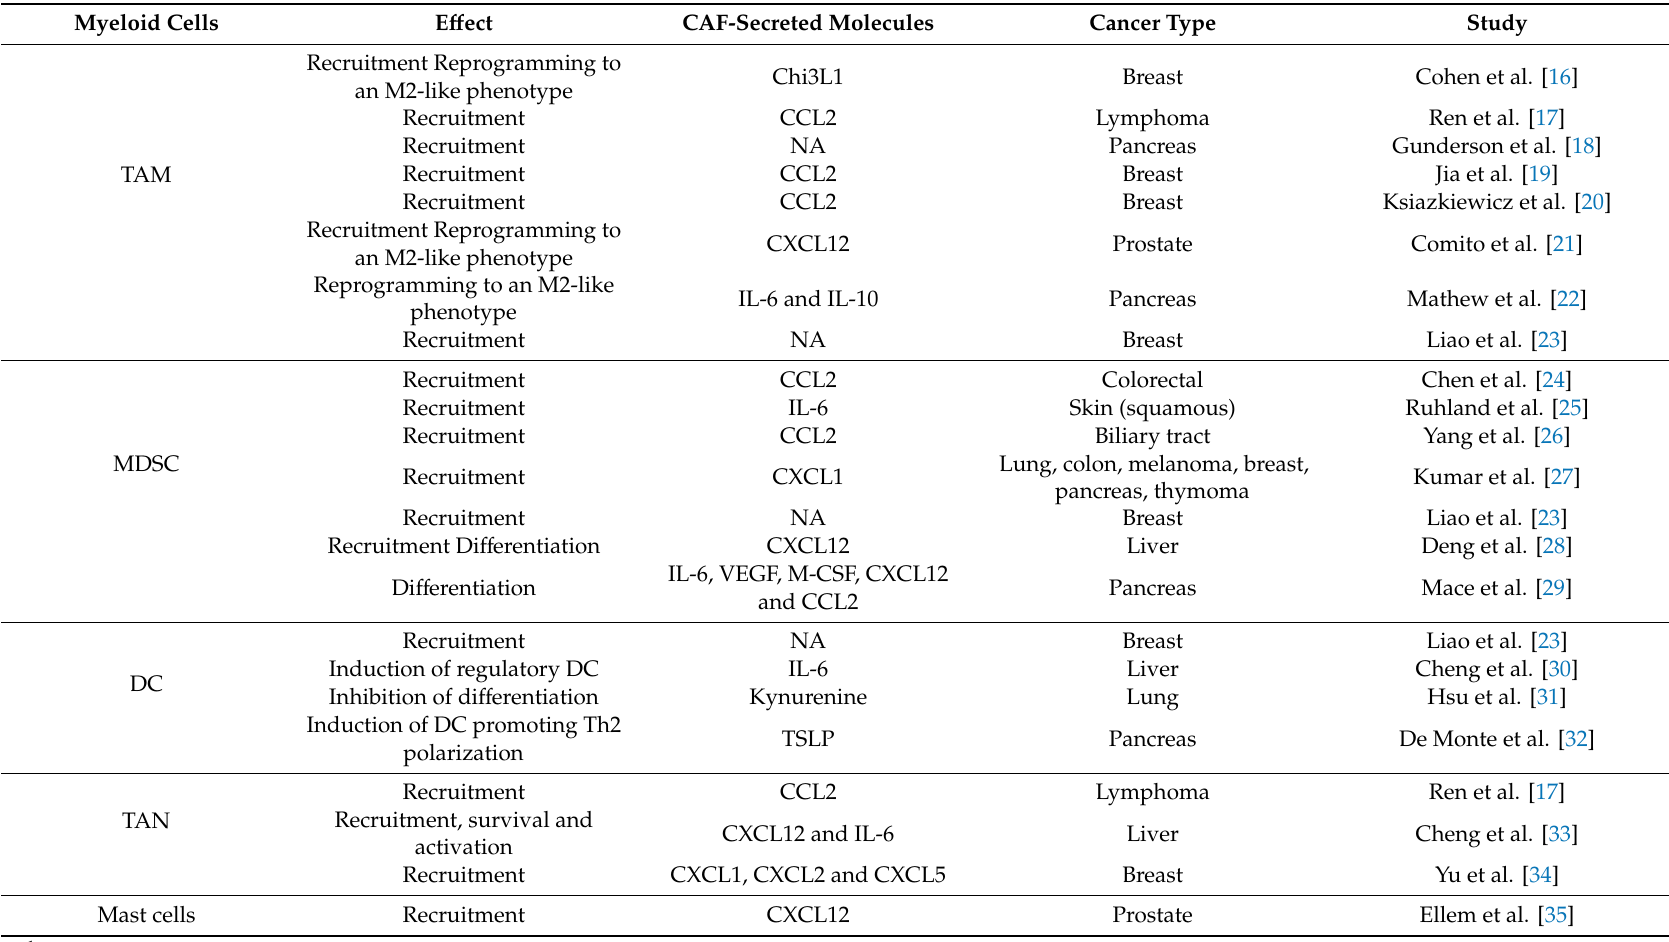
Table 1. Summary of studies evaluating modulation of myeloid cells by CAFs 1